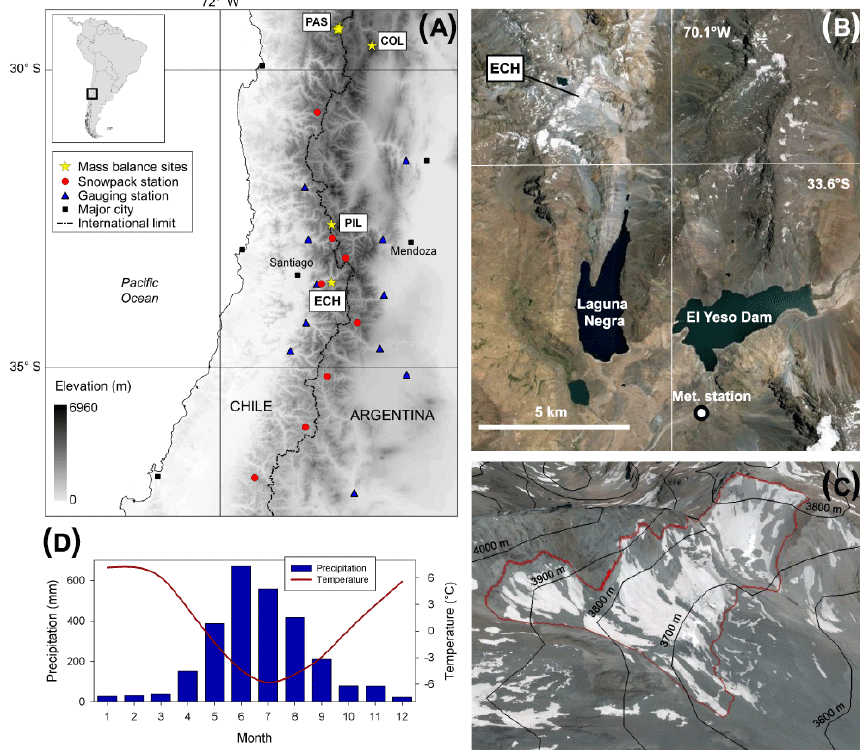
Figure 1. Panel (a) depicts a map of the Central Andes of Chile and Argentina showing the location of the Echaurren Norte glacier (ECH), Piloto Este glacier (PIL) and several smaller glaciers with mass-balance records in the Pascua Lama (PAS) and Cordillera de Colanguil (COL) areas. The locations of the snowpack and streamflow stations discussed in the text are also shown (Tables 1 and 2). In panel (b) a general view of the El Yeso area, showing the location of ECH, El Yeso Dam and the associated meteorological station is given. Laguna Negra is a natural lake that receives the meltwater from ECH. Base image acquired on 5 January 2014 and downloaded from Google Earth. Panel (c) provides a closer oblique view of Echaurren Norte as observed in 2014 and in the early 1970s (outlined in red and based on Peña and Narbona, 1978). Note that the glacier has remained in roughly the same position but has thinned markedly over the last decades. Panel (d) shows seasonal variations in temperature and precipitation at the lower reaches of ECH (3700ma.s.l.) extrapolated from the El Yeso meteorological station (see Sect. 2.2 for details). Note that the bulk of precipitation occurs during the coldest months of the year (December–March